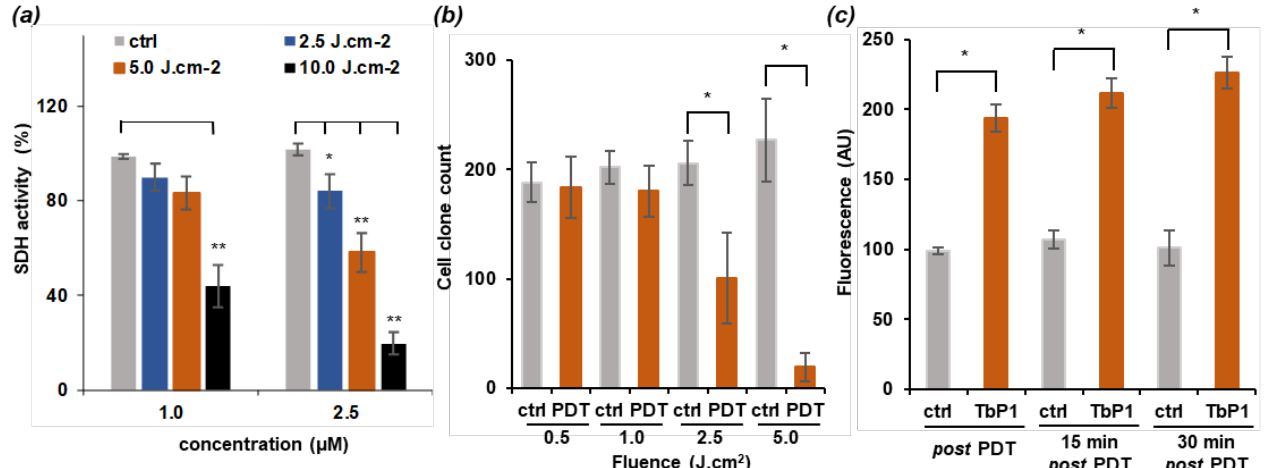
Figure 5. U-251 MG cell photodynamic effect. Cells were treated with AGuIX@Tb-P1 for 24 h before red-light exposition (2.5 to 10.0 J cm −2 ). ( a ) cell viability was measured 24 h post treatment using the MTT assay. ( b ) Clonogenic assays after PDT treatment with increasing fluences. Clonogenic capabilities are expressed relative to control cells. Results are means ± S.D. ( n = 12 wells/condition); * p < 0.05; (Kruskal-Wallis test and post-hoc by the Mann-Whitney test). ( c ) Cells were pre-treated with 2.5 µM AGuIX@Tb-P1 (TbP1), followed by photodynamic treatment at 2.5 J cm −2 . Reactive species were quantified by DCF2-DA probe using flow cytometry. In ( a , c ), results are means ± S.D. of three determinations from three independent experiments. * p < 0.05; ** p < 0.001 (Kruskal-Wallis test and post-hoc by the Dunn’s test). Abbreviations: ctrl, cells treated with AGuIX@ conjugates without light exposure; SDH, succinate dehydrogenase; UA, arbitrary unit.